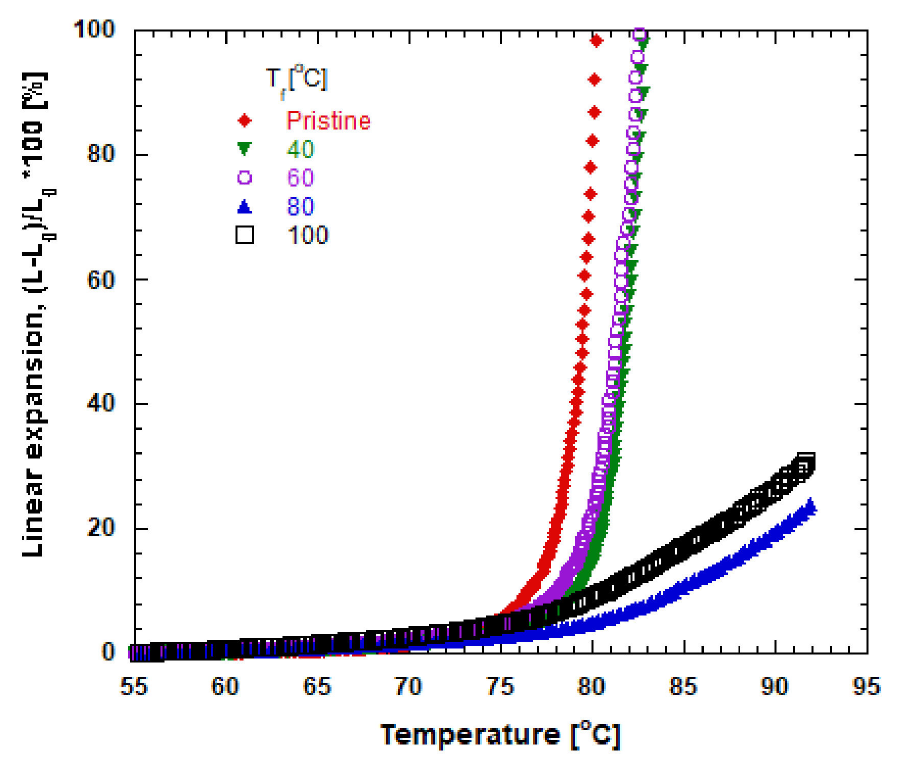
Figure 5. Linear expansion of the PET–PEN rod as function of environment and foaming